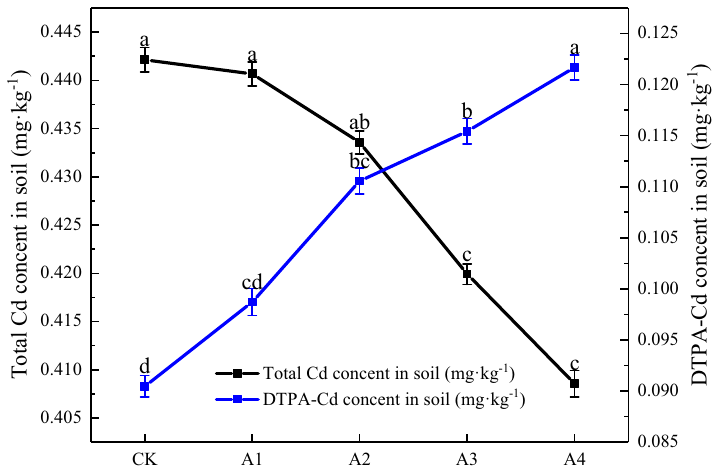
Figure 3. Soil total contents of Cd and DTPA-Cd in different GLDA treatments.